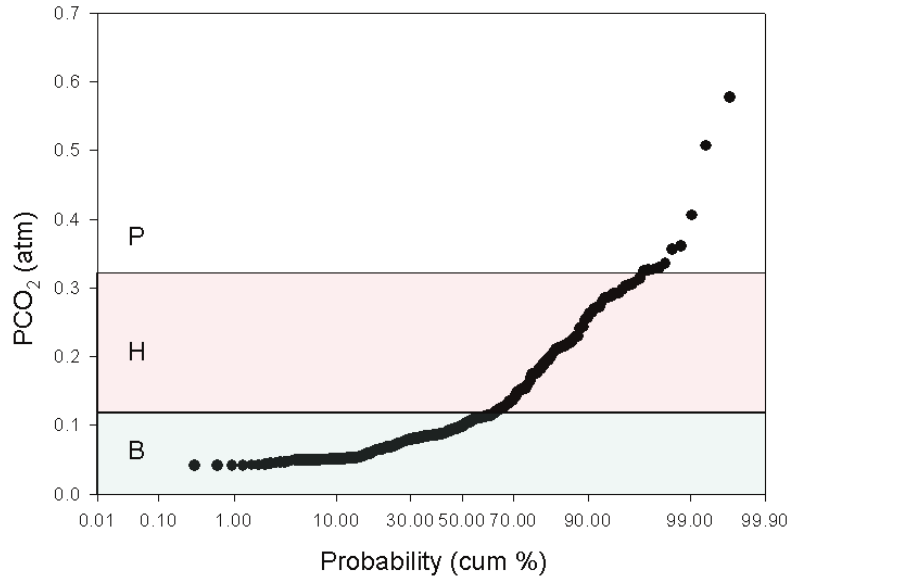
Figure 8. P values measured for the Saibbo well plotted against cumulated probability of P CO2 P, H and B indicate the three subsets defined in this analysis (see main text).